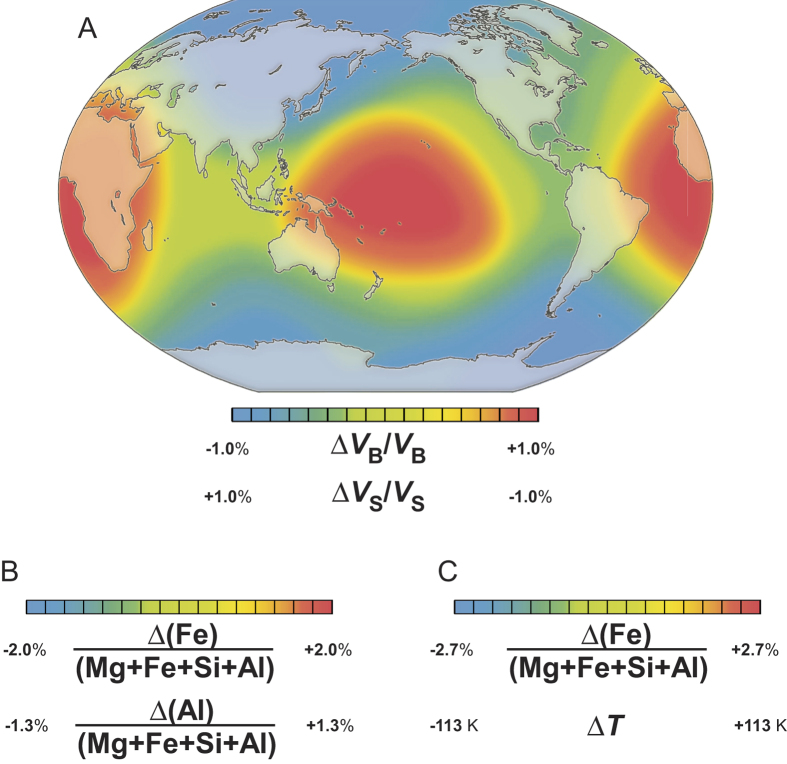
Schematic image of regional variation of seismic velocities, chemical composition of bridgmanite, and temperature variation at depth between 2000 and 2891 km.(A) Red color indicate the anomaly of ΔVB > 0 > ΔVS. The map outline was made using CraftMAP (http://www.craftmap.box-i.net/). (B) The case of ΔT (difference from the average temperature) = 0. Fe and Al contents are the highest in the red regions. (C) The case of ΔAl/(Mg + Fe + Si + Al) = 0. Fe content is the highest in the red regions, where temperature is higher than the average temperature by 113 K. The map was colored based on ref. 6.